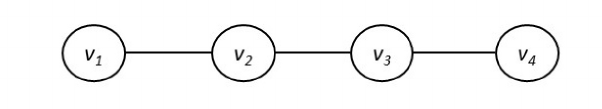
Figure 1. Stochastic heat equation on a linear